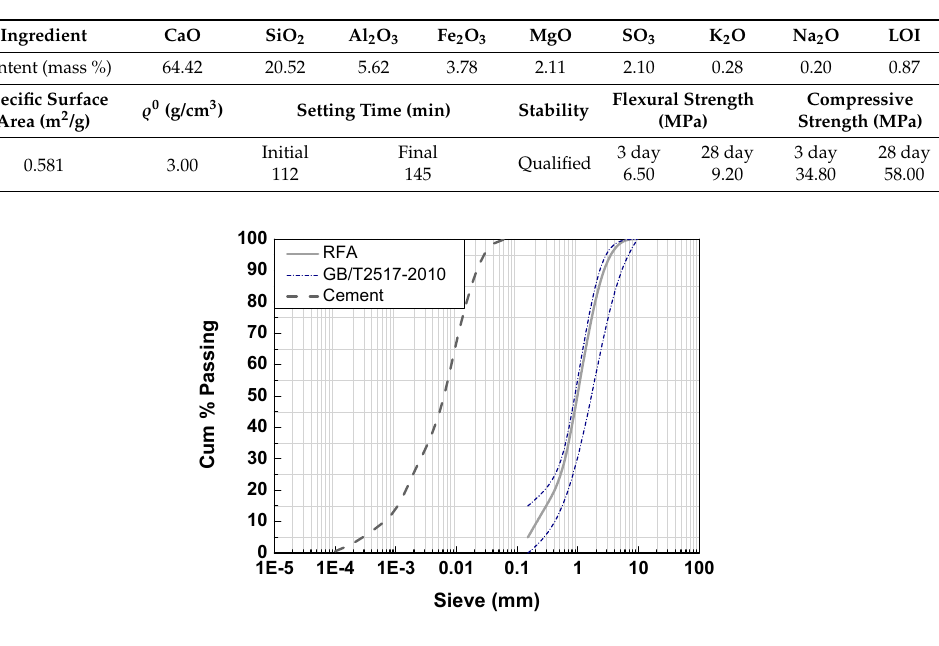
Figure 1. Particle-size distribution of recycled fine aggregate.